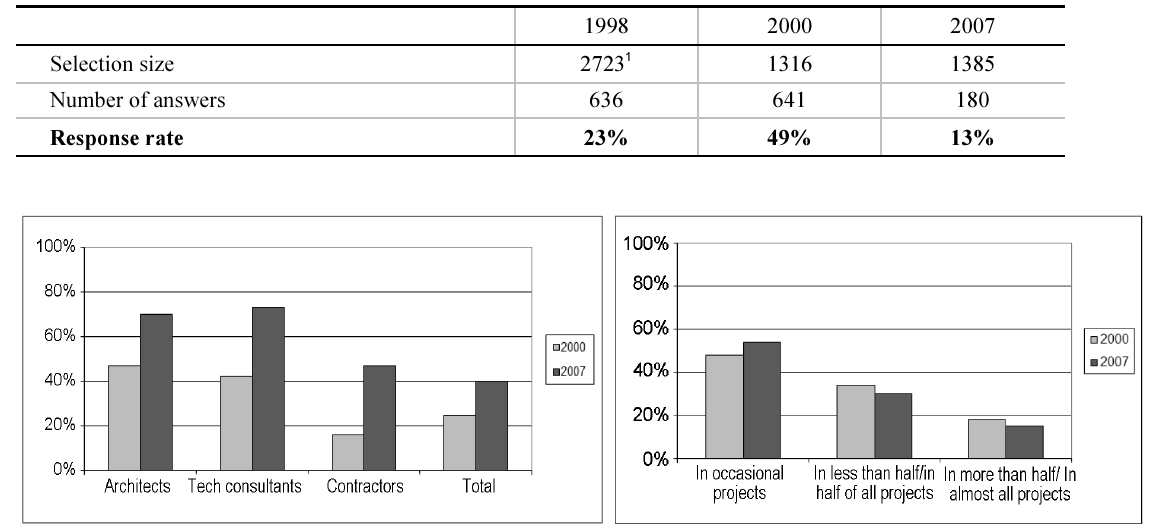
Fig. 1. Proportion of employees in workplaces, where EDM has been used (left), frequency of use (right)